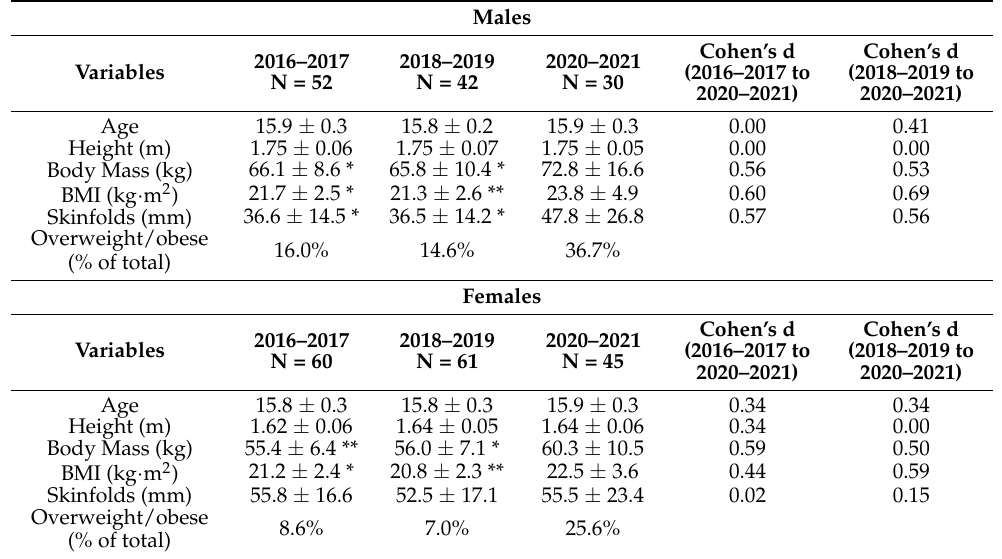
Table 1. Anthropometric measurements at different school years by sex (mean ± SD).